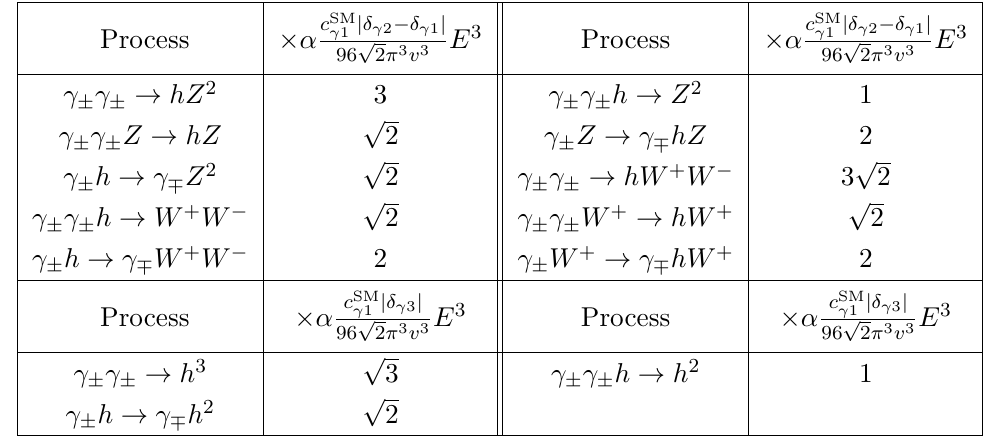
Table 2 . | ˆ M | of the 5-body unitarity-violating processes arising from the modification of the Higgs coupling to γγ